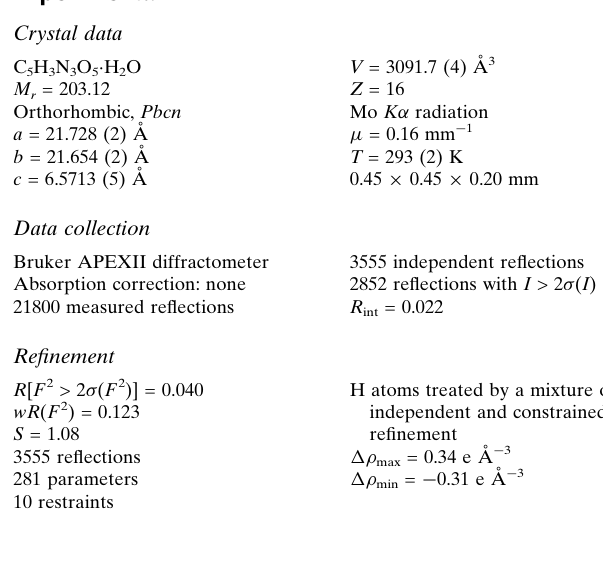
Bruker APEXII diffractometer Absorption correction: none